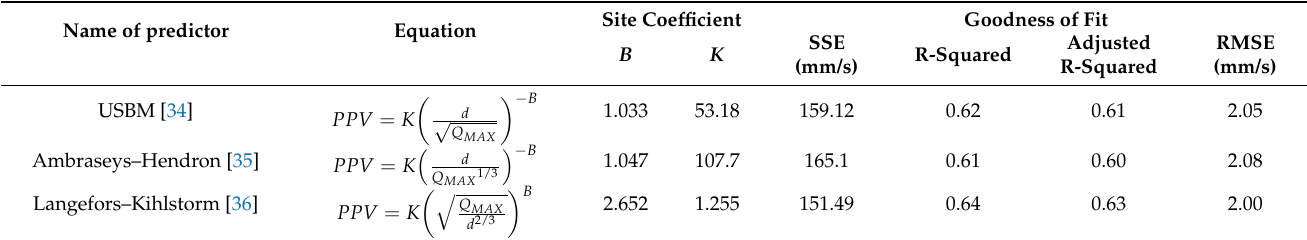
Table 5. Estimated site coefficients based on the training data and goodness of fit of each prediction equation. Name of predictor